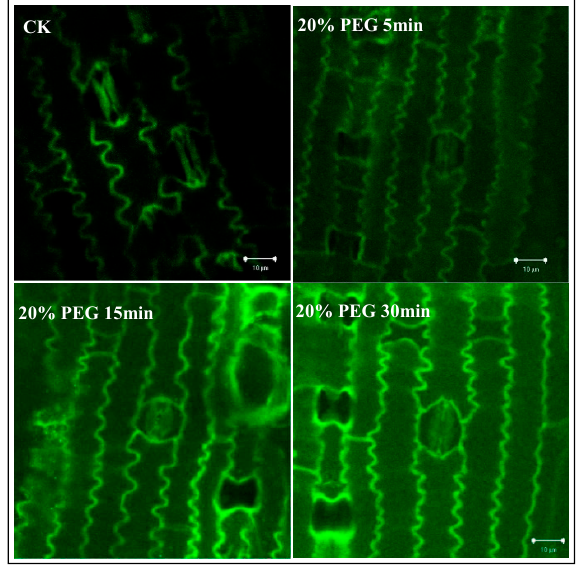
Figure 7. Localization of cellular Ca 2+ dynamics in leaves of P. edulis seedlings. Calcium-fluorescence localization of the leaves of the P. edulis seedlings under drought stress for 5 minutes, 15 minutes, and 30 minutes induced by 20% PEG, respectively. The green fluorescence intensity represents the Ca 2+ concentration and is positively correlated with the Ca 2+ concentration.